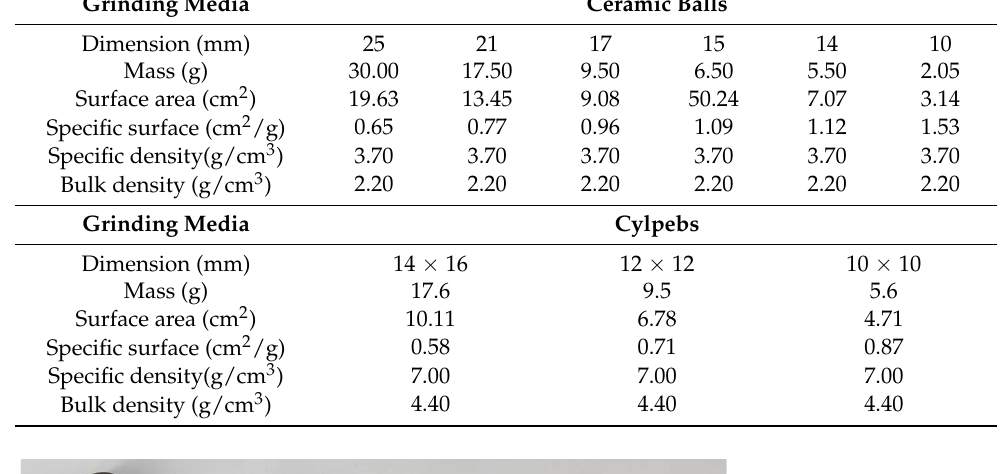
Table 3. Physical properties of grinding media.